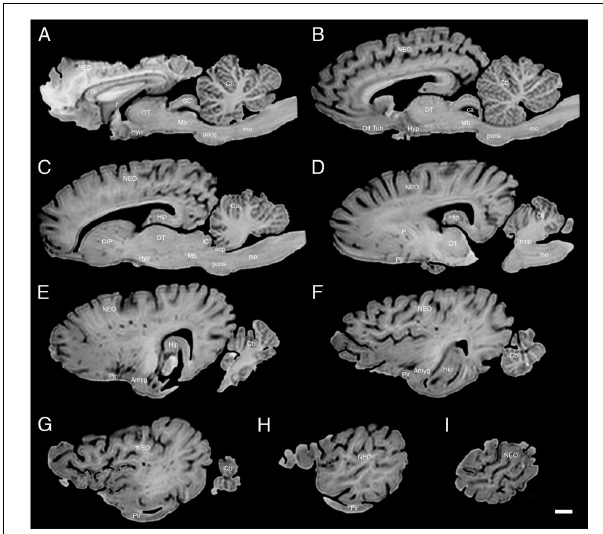
FIGURE 5 | A series of sagittal structural MR images through the brain of the white rhinoceros ( C. simum ). (A) is the most medial section and (I) is the most lateral section, with each section having a thickness of 2 mm and each section being 6 mm apart. Note the typically mammalian topography of the various regions and structures of the brain. Scale bar = 2 cm. Amyg, amygdaloid body; C, caudate nucleus; ca, cerebral aqueduct; Cb, cerebellum; cc, corpus callosum; DT, dorsal thalamus; f, fornix; Hip, hippocampus; Hyp, hypothalamus; IC, inferior colliculus; NEO, neocortex; Mb, midbrain; mcp, middle cerebellar peduncle; mo, medulla oblongata; Olf. Tub, olfactory tubercle; P, putamen; Pir, piriform cortex; SC, superior colliculus; scp, superior cerebellar peduncle.